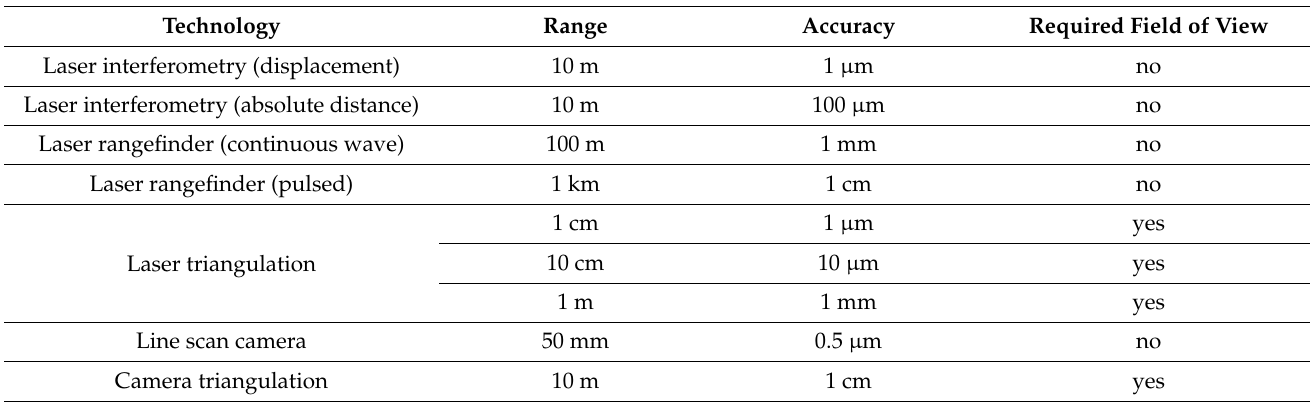
Table 1. Summary of common measurement performances of different optical technologies (orders of magnitude). Technology Range Accuracy Required Field of View Laser interferometry